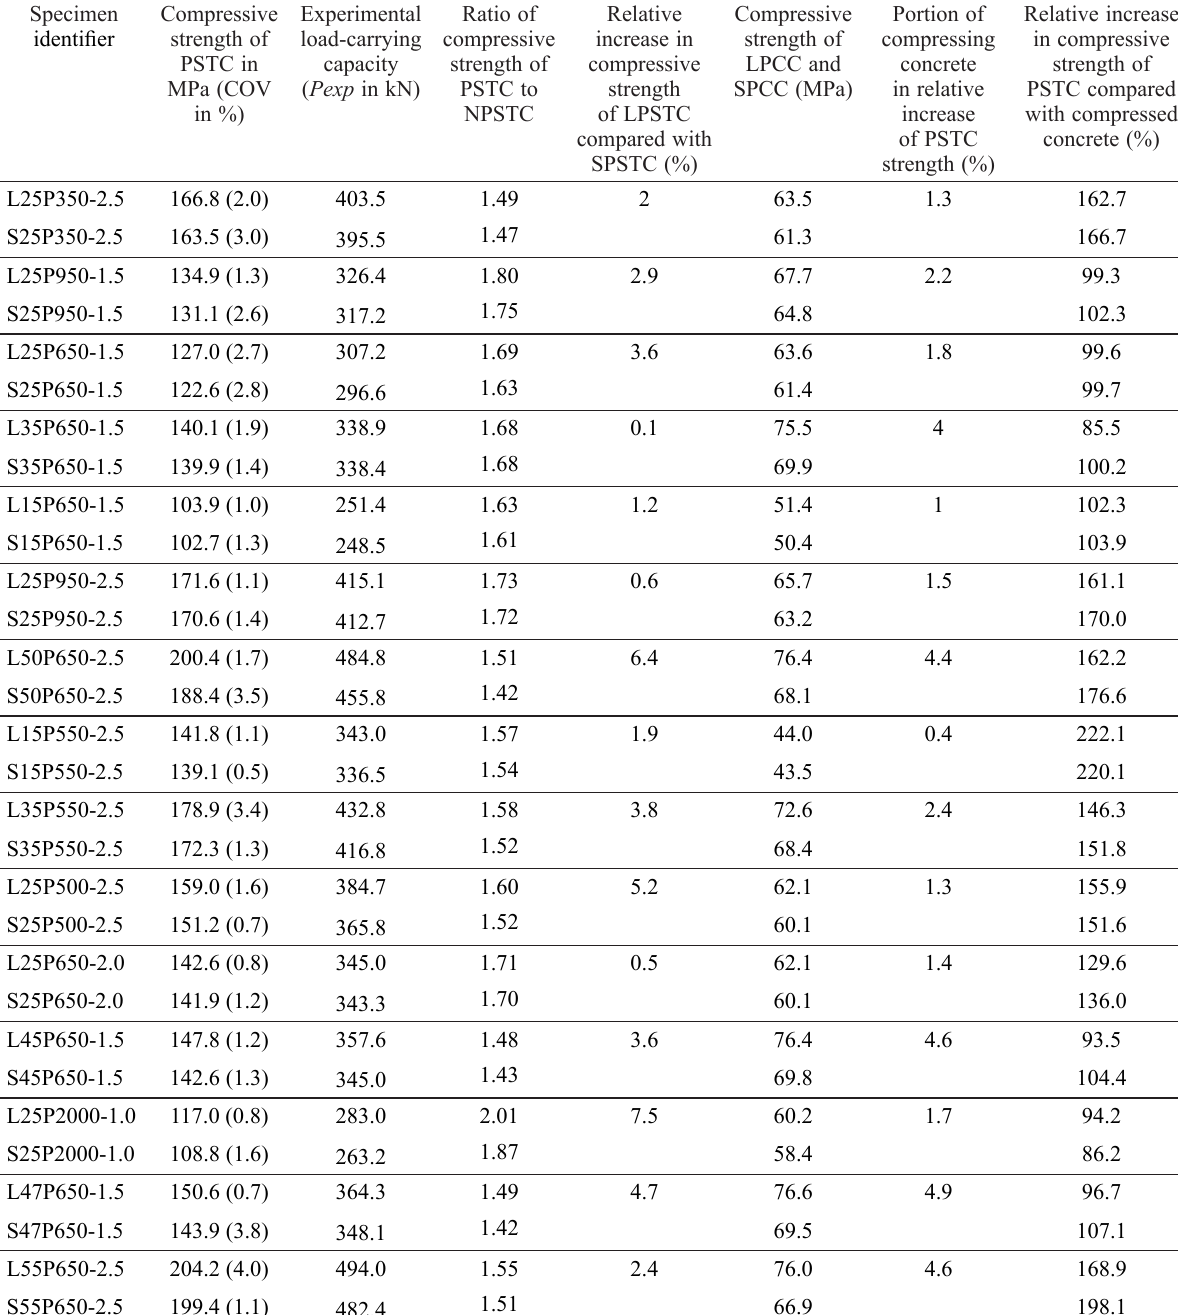
Table 4. Compressive strength results of actively-confined